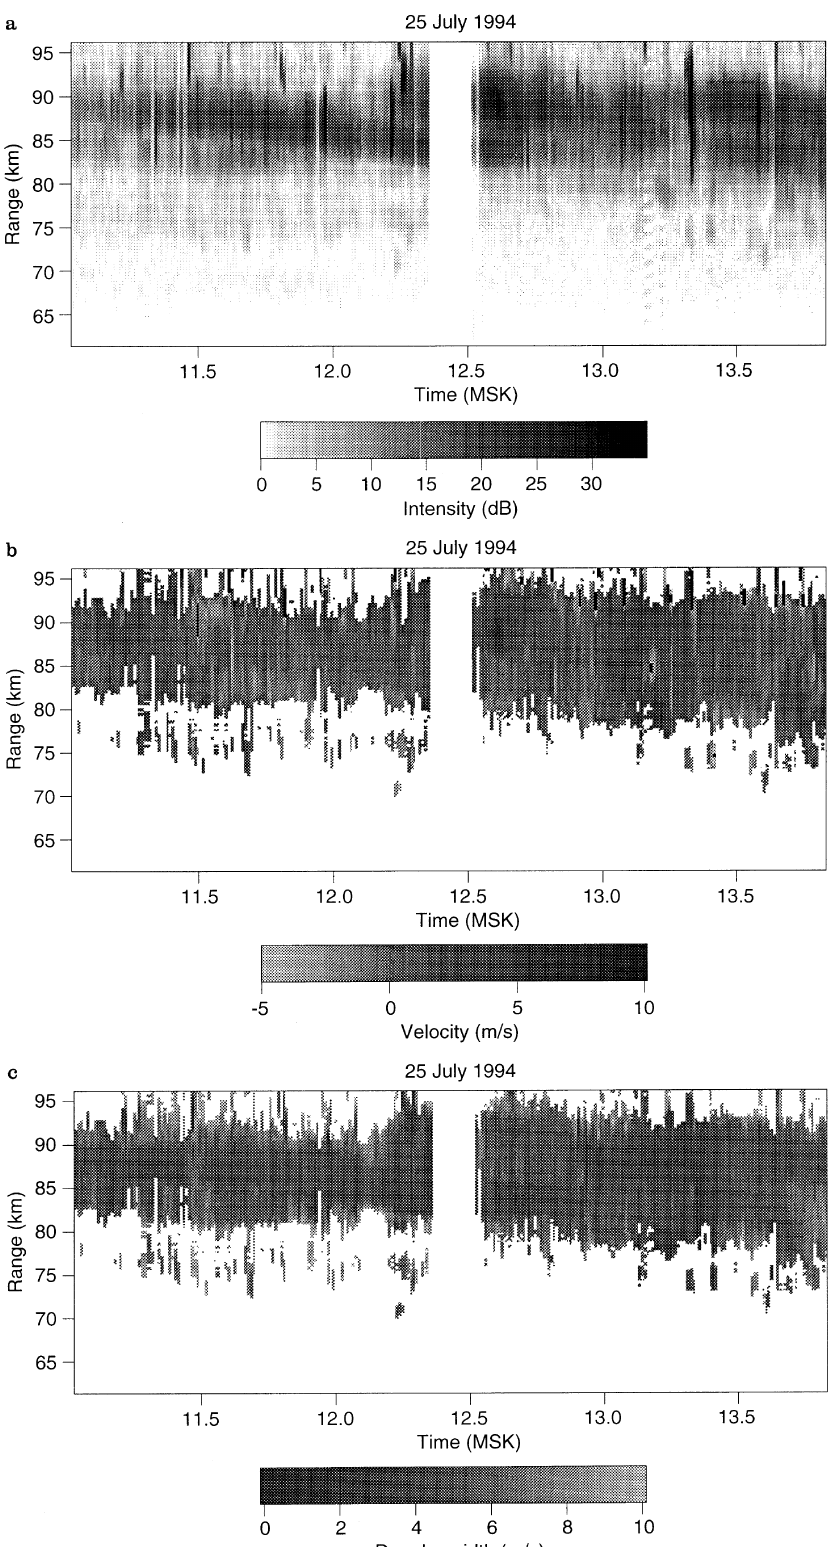
Fig. 1a–c. Height-time plots of backscat- tered mesospheric signals obtained on 25 July 1994. a Intensities of observed echoes. b Vertical velocities (positive values corres- pond to downward motion). c Doppler spectral widths. The last two plots show only data with echo intensity above